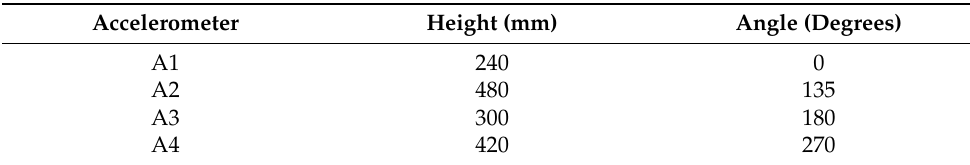
Table 1. Accelerometer location.